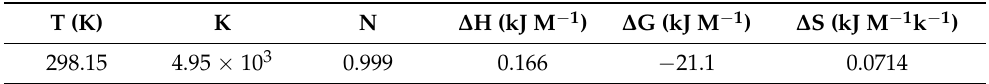
Table 1. Binding parameters of the interaction between SOD and